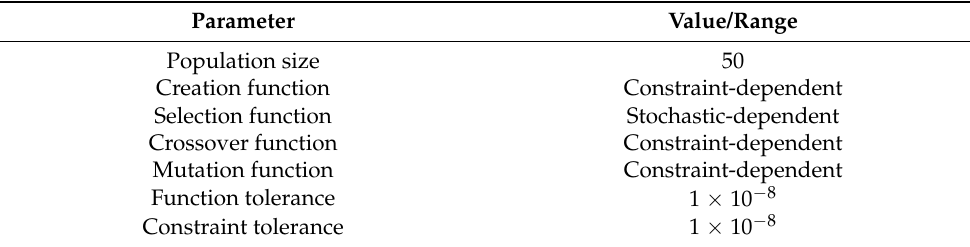
Table 4. Genetic Algorithm (GA) Optimization